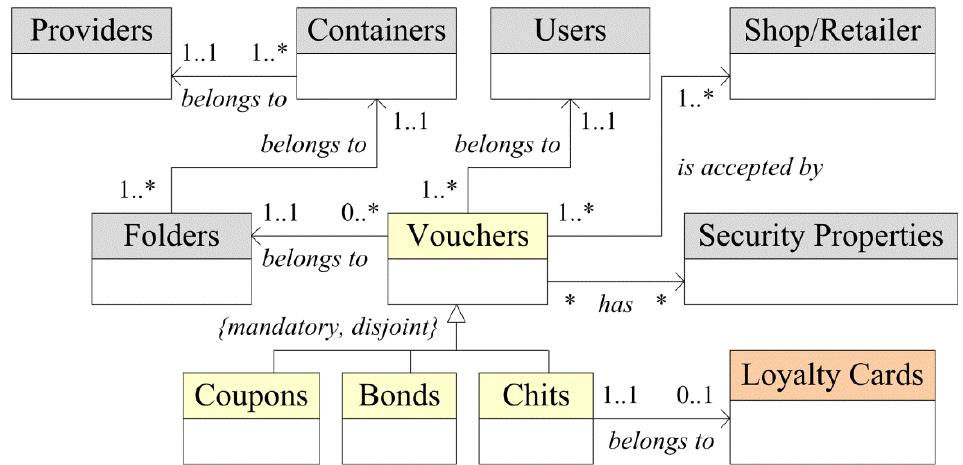
Figure 1. Class diagram corresponding to voucher